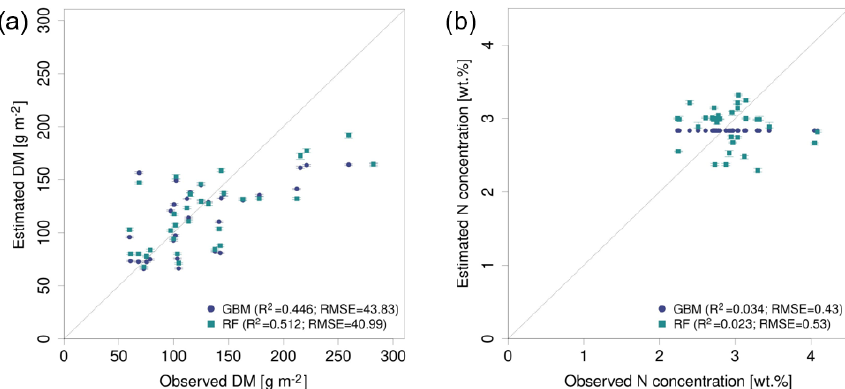
Figure 8. Observed vs. estimated DM (left) and N concentration (right) in the external site EL using SEQ data with the best performing predictor set: (a) DM models based on PS6 (raw reflectance data + VI + canopy height) and (b) N concentration models based on PS4 (canopy